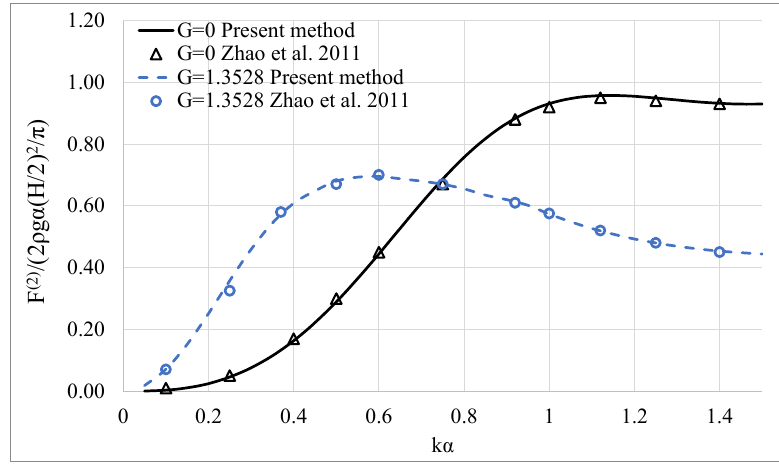
Figure 4. Comparison of the present method results against those from Zhao et al. [61], concerning the horizontal drift forces on a porous cylinder.